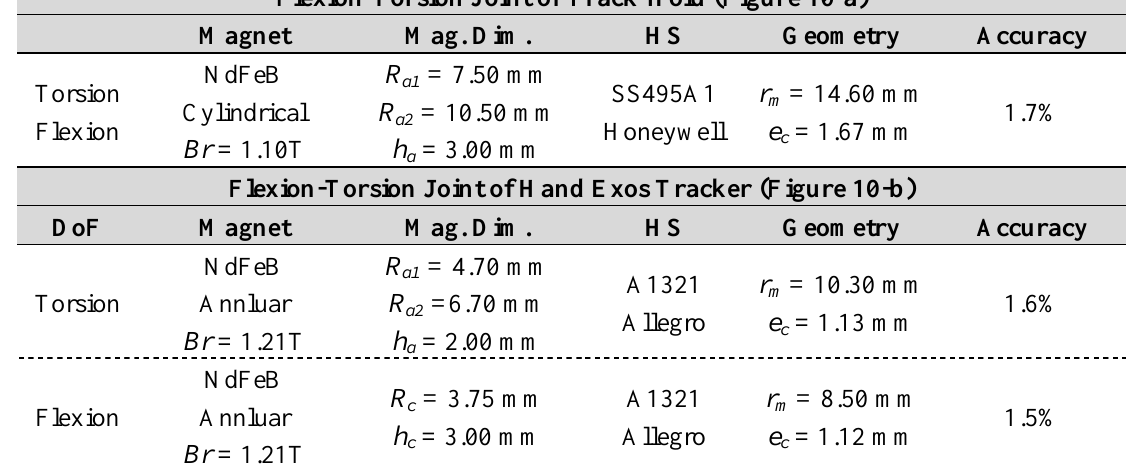
Table 3. Table of the employed sensor for the two types of Torsion-Flexion joint developed for the implementation of the two trackers. Flexion-Torsion Joint of Track-Hold (Figure 10-a) Mag.